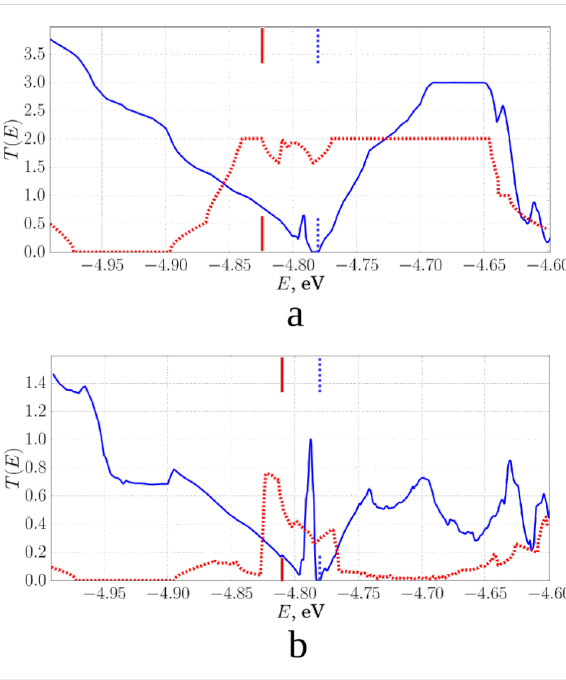
Figure 7: Plots of the transmission functions for two-layer (blue) and single-layer (red) composites (the tube length in the composite was equal to 1.84 nm): a) in the direction of the X -axis, along the zigzag edge; b) in the direction of the Y -axis, along the armchair edge. In ad- dition, the values of the Fermi energy for composites are shown by short lines of the corresponding